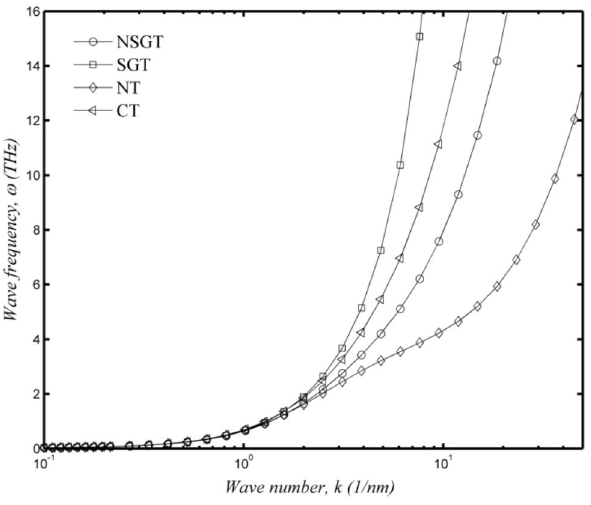
Fig. 9 The wave frequency variations with the strain gra- dient length scale and nonlocal parameters